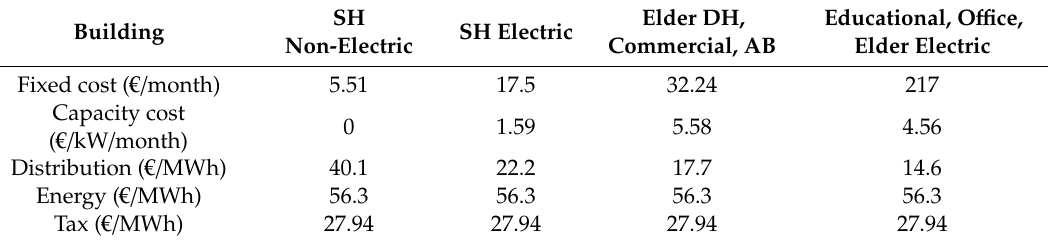
Table 5. Electricity costs for di ff erent building types [52,53].